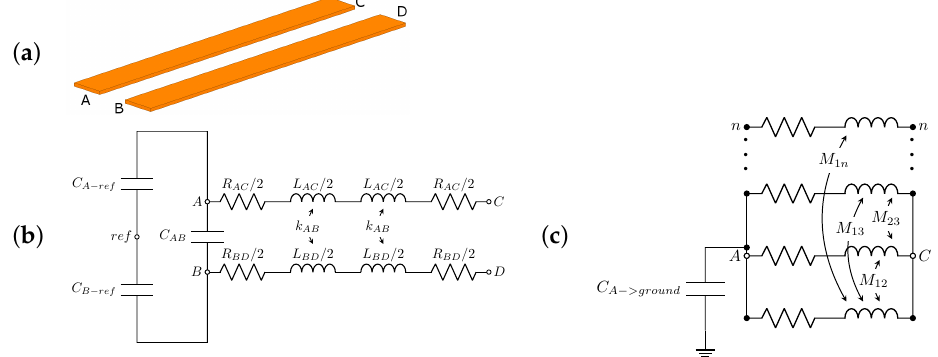
Figure 7. The example of two conducting copper track ( a ) geometry view ( b ) model generated with Q3d Extractor ( c ) model generated with PEEC